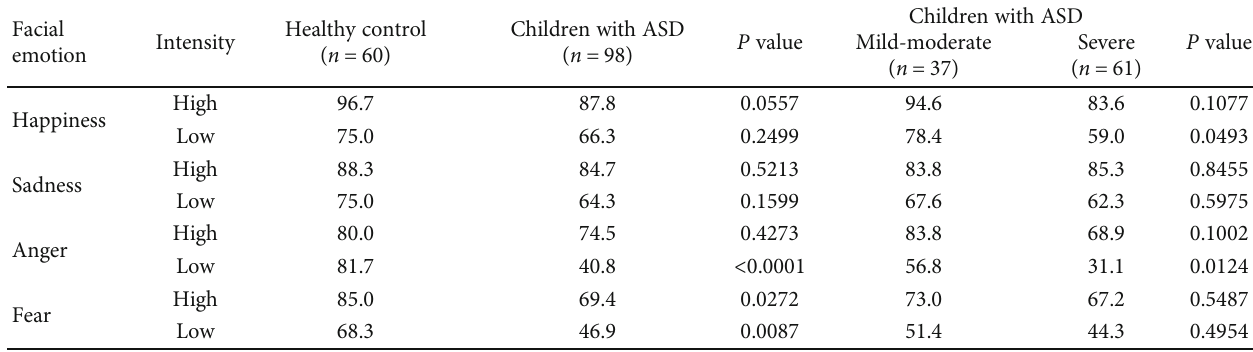
Table 2: Comparison of accuracy (%) in facial emotion recognition.